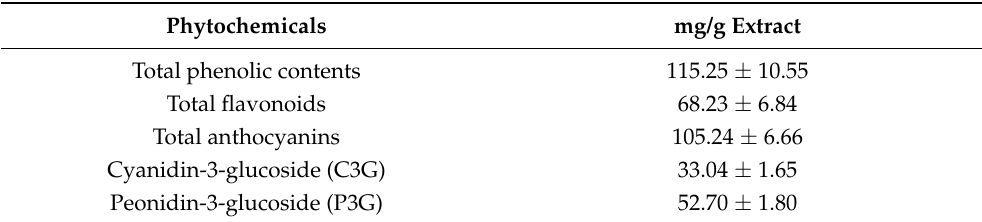
Table 2. Phytochemical characteristics of anthocyanin-rich fractions derived from black rice germ and bran (BR